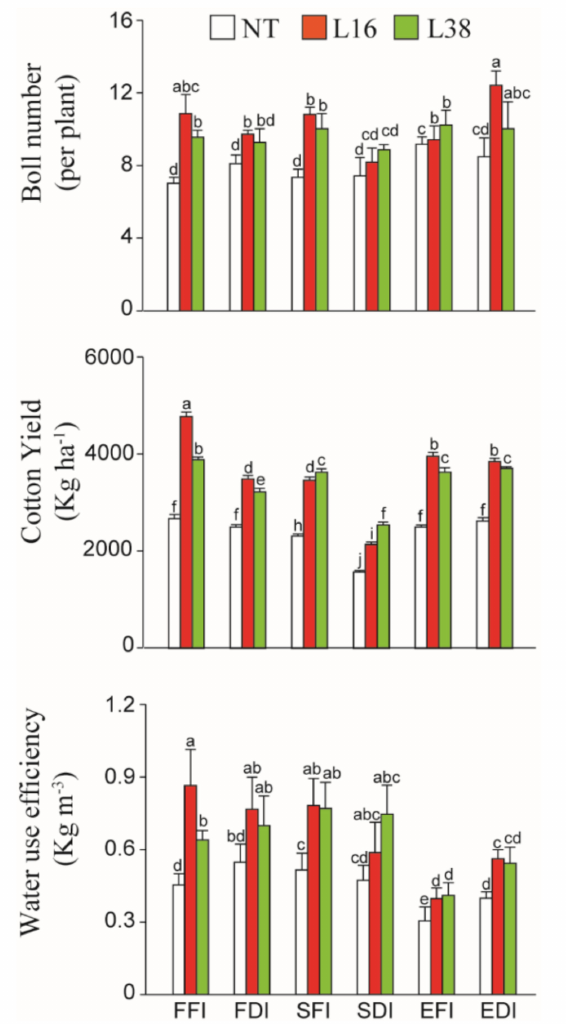
Figure 5. Effects of different treatments on boll number, cotton yield and WUE in 2016, 2017, and 2018. Full forecast irrigation (FFI); 75% of full forecast irrigation (FDI); full soil moisture irrigation (SFI); 75% of full soil moisture irrigation (SDI); full flood irrigation (EFI); 75% of full flood irrigation (EDI). Different letters indicate significant differences between transgenic lines and NT following Duncan’s multiple range tests at the 5% level of